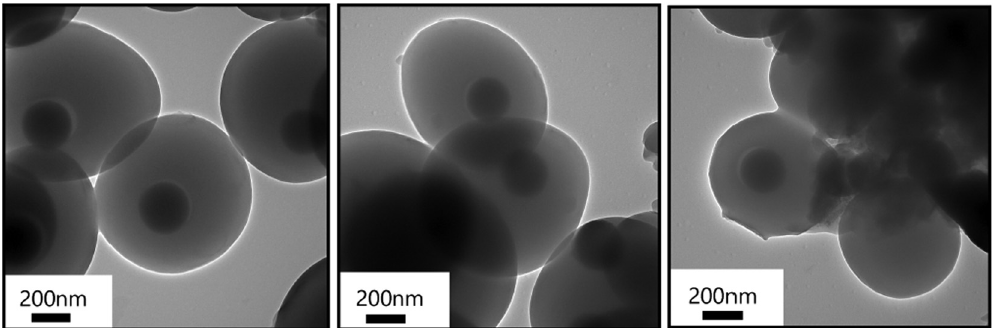
Figure 3: TEM images of the PMOS/SiO 2 – MAPTMS core – shell particles. The polymer shell was cross - linked with DVB.